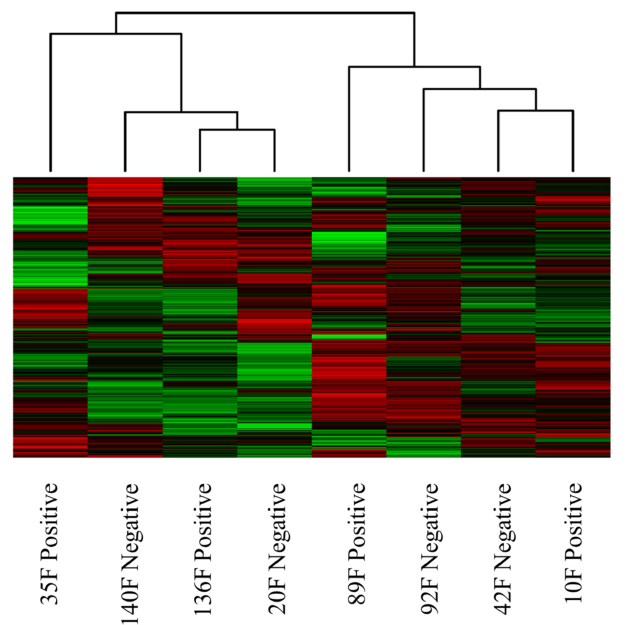
Figure 1. Heatmap and clustering analysis of feedlot cattle that were culture positive or negative for Salmonella in the sub-iliac lymph node, samples clustered based on the relative similarity of the kinome profiles. The interspersing of Salmonella -positive and -negative animals indicates that infection status is not the overriding differentiator of the two groupings. Each column represents a tissue sample; each row is a peptide. Red represents relative increase in phosphorylation and green relative decrease. Table 1. Details of cattle positive or negative for Salmonella in the sub-iliac lymph node collected for kinome analysis. Table 2. The top 12 KEGG pathways in the sub-iliac lymph nodes collected from feedlot cattle at slaughter that were culture positive or negative for Salmonella . The list of represented pathways was generated by taking the statistically significant peptides and inputting this peptide list into the online STRING database. Presented here are the top 12 pathways from the input data. The bold pathways are those involved in the immune response (total immune peptides: